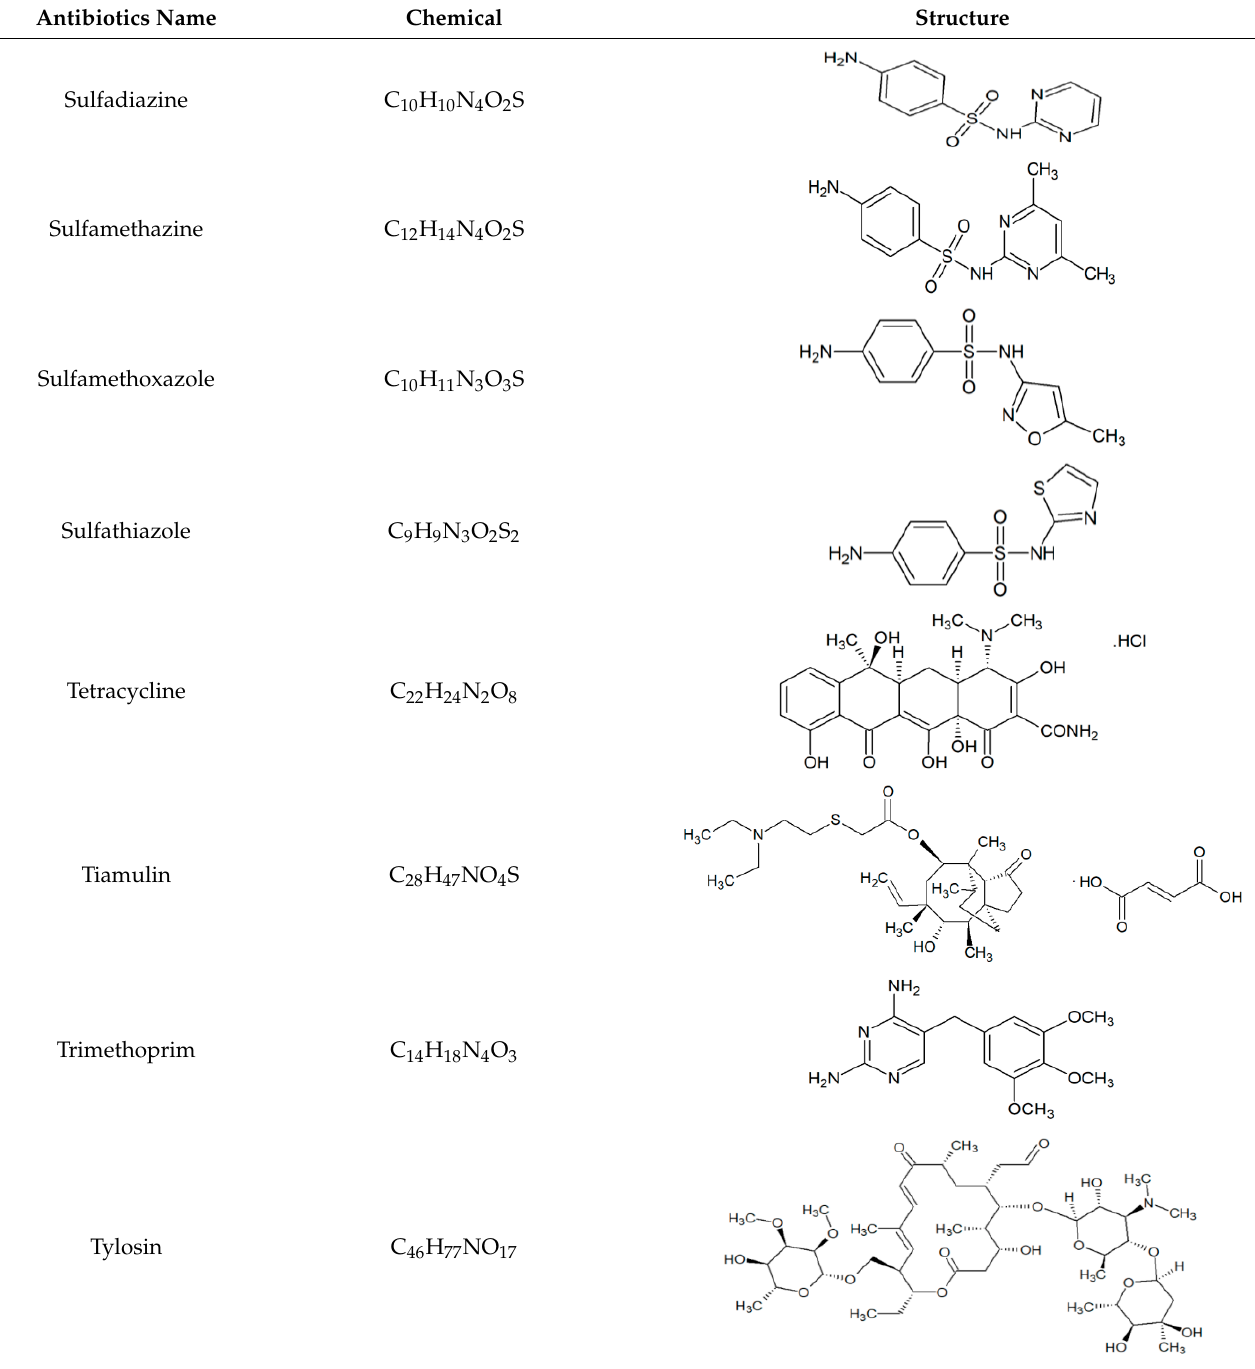
Table 2. Characteristics of real livestock wastewater, obtained from a livestock wastewater treat- ment plant in Jeollanam-do, Korea.